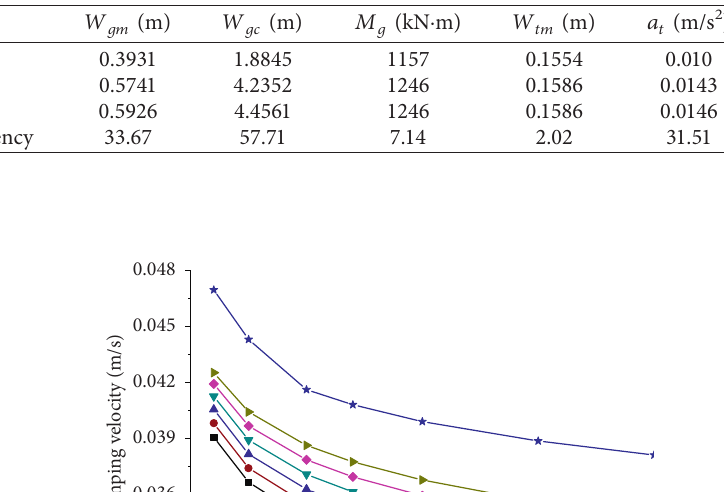
Table 5: Peak values of bridge dynamic response.